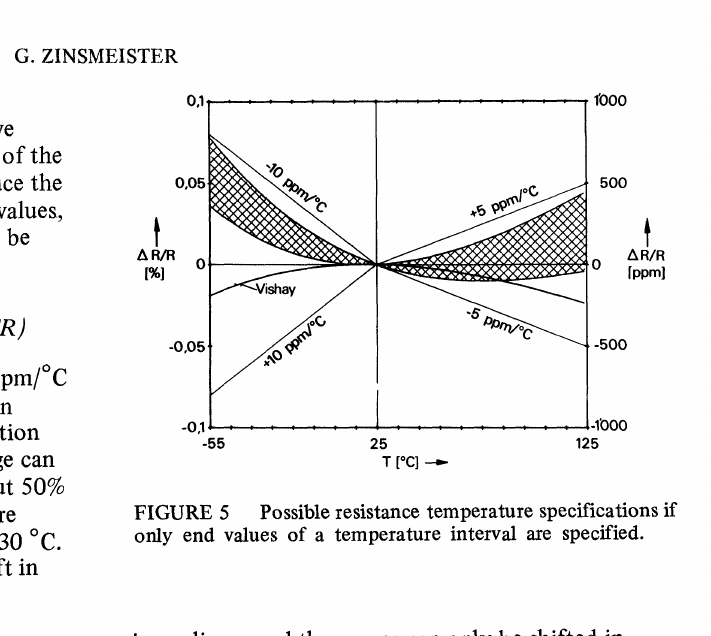
is nonlinear and the curves can only be shifted in parallel but not turned e.g. in a desired more horizontal direction. The temperature dependence of the TCR shown in Figure 3 corresponds to the resistance versus temperature curves given in Figure 4. Usually the resistance values are only specified for the end points of a certain temperature range. If we choose the 2 ranges-55 C to 25 C and 25 C to 125 C, then fairly tight tolerances can be kept as contains the values of 18 resistors measured on 3 different substrates. For a comparison the measured curve for a 10 k2 Vishay resistor is also given. This resistor shows an opposite temperature dependence and a very small absolute TCR.